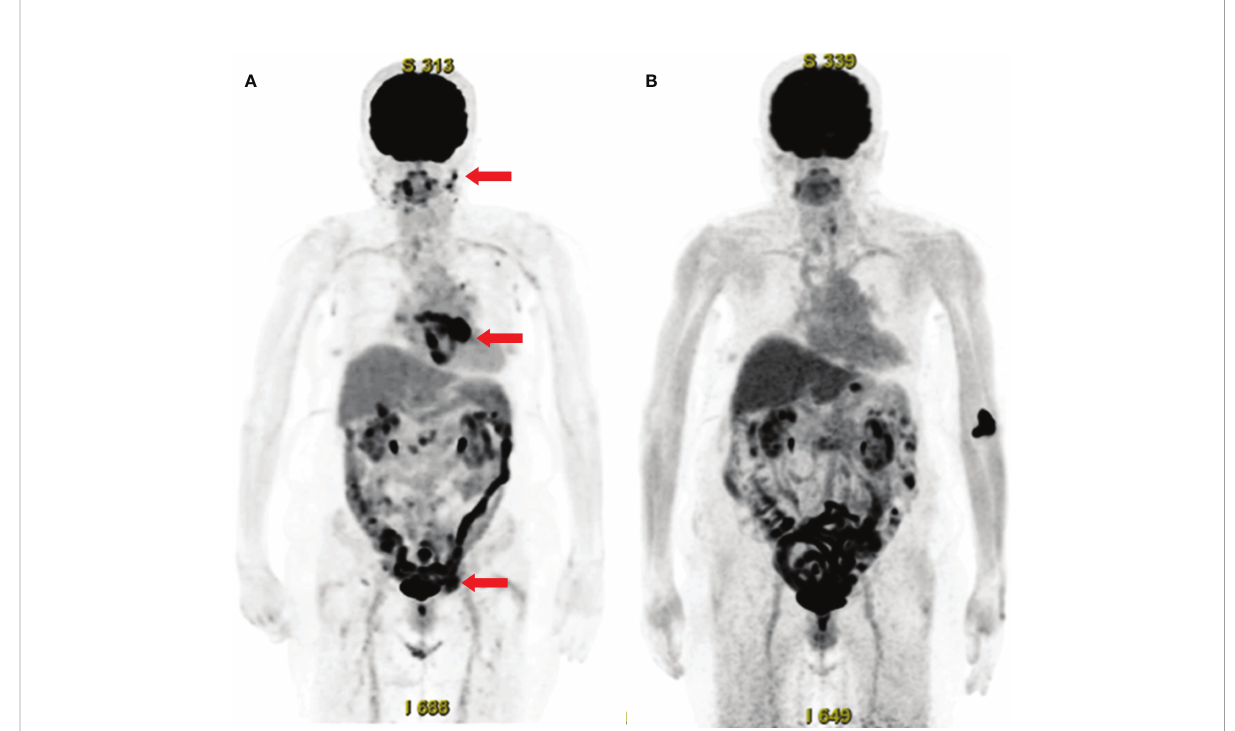
FIGURE 3 Whole-body 18 F- fl uorodeoxyglucose (FDG)-positron emission tomography with computed tomography (PET-CT) before and after treatment. (A) FDG-PET-CT before treatment, showing abnormal FDG uptake in the facial skin, peri-atrial, pelvic (arrows), cervical, axillary, and inguinal lymph nodes, and colon. (B) Follow-up FDG-PET-CT after treatment, showing the disappearance of abnormal FDG